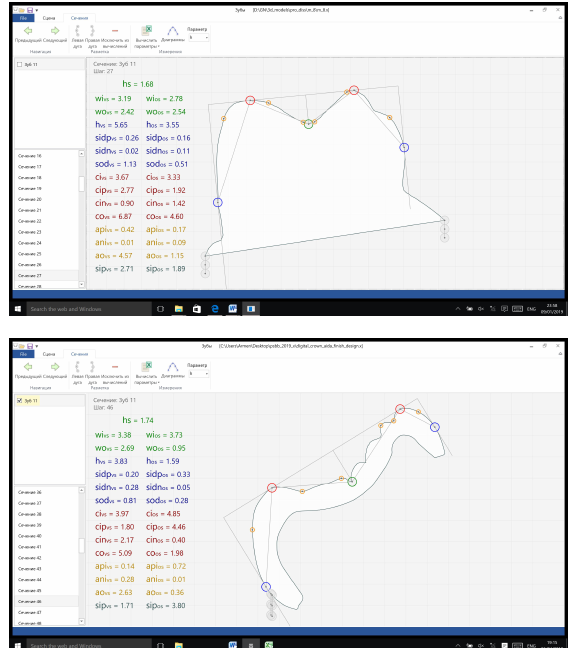
Figure 7. Tooth (upper) and crown (lower) contours with measurement outlines and